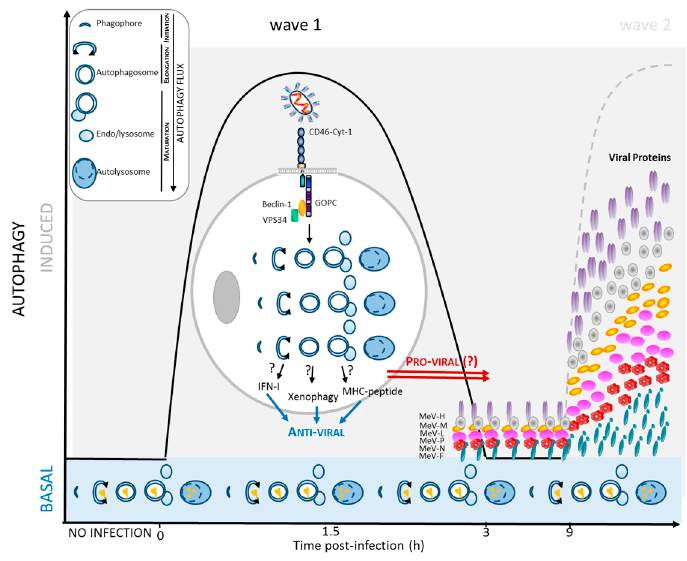
Figure 1. Early induction of autophagy upon MeV infection. Attenuated MeV strains induce autophagy as soon as 1.5 h after infection via a CD46/GOPC (Golgi Associated PDZ and Coiled-Coil Motif Containing)-dependent pathway. This wave of autophagy could contribute to protecting the infected cells and surrounding cells from further infections due to its anti-viral potential. On the other hand, infectious MeV could use such an autophagy induction to facilitate its own replication (pro-viral). Before induction of a second wave of autophagy, which correlates with the accumulation of viral proteins, the first transient wave of autophagy ceases. Basal autophagy remains possibly efficient during the all cycles of MeV infection. Note that virulent/clinical strains of MeV, which do not bind to CD46, do not induce such an early autophagy wave. Upper left panel: schematic representation of the main steps of the complete autophagy flux process. (blue arrows = anti-viral effect; red arrows = pro-viral effect; dotted line = wave 2).